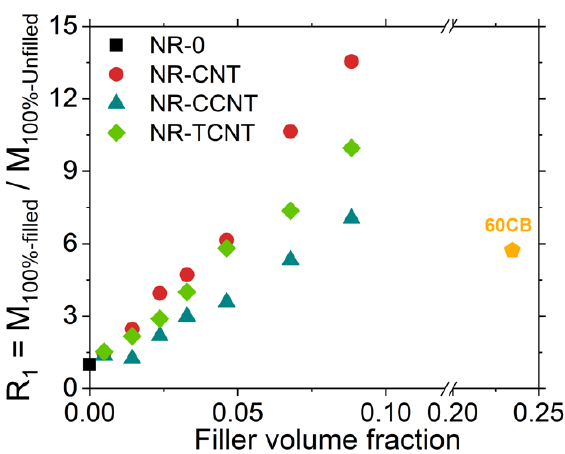
Figure 12. Variation of the reinforcement degree with the volume fraction of pristine (CNTs) and functionalized (CCNTs and TCNTs) carbon nanotubes compared to the performance of a sample filled with carbon black (CB).